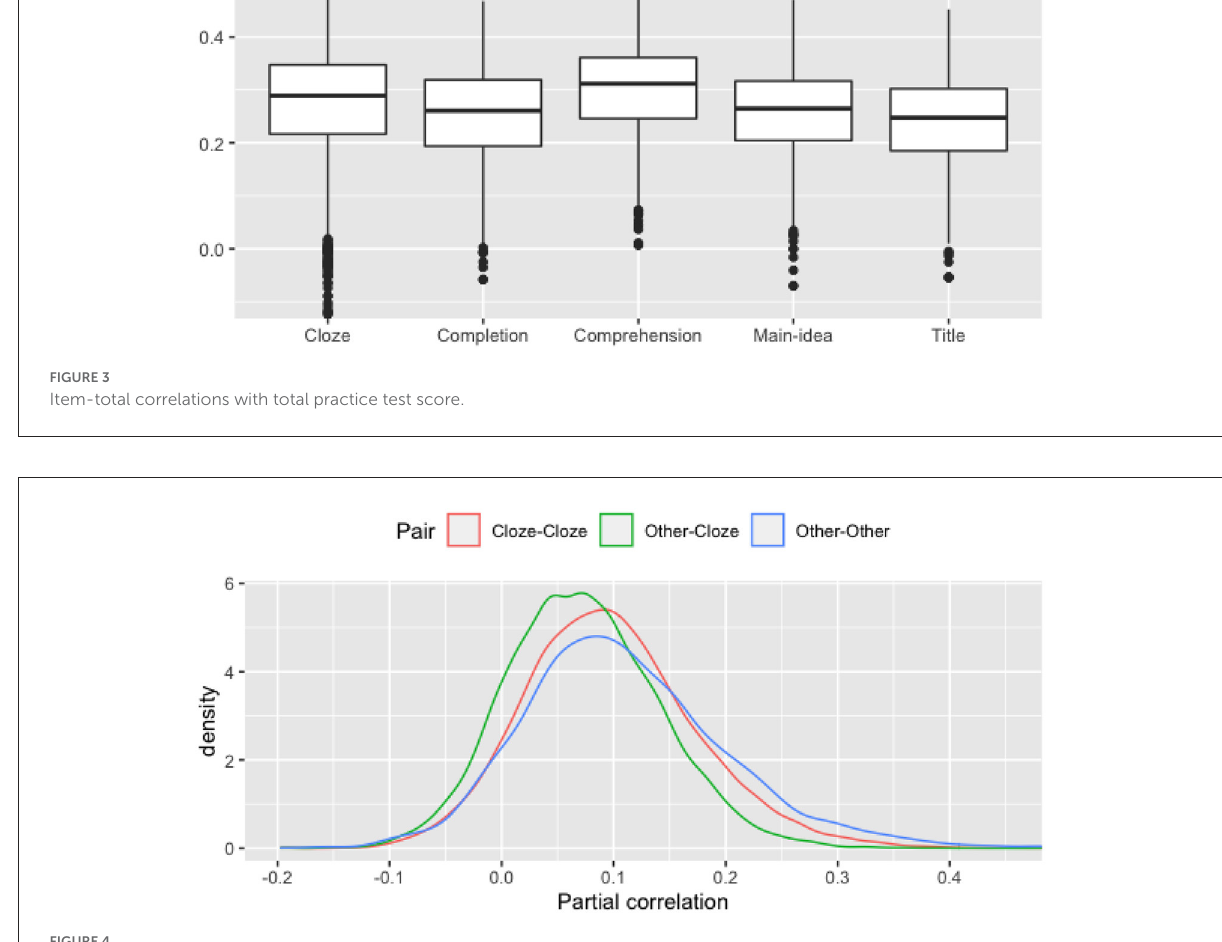
FIGURE4 Partial correlations between item